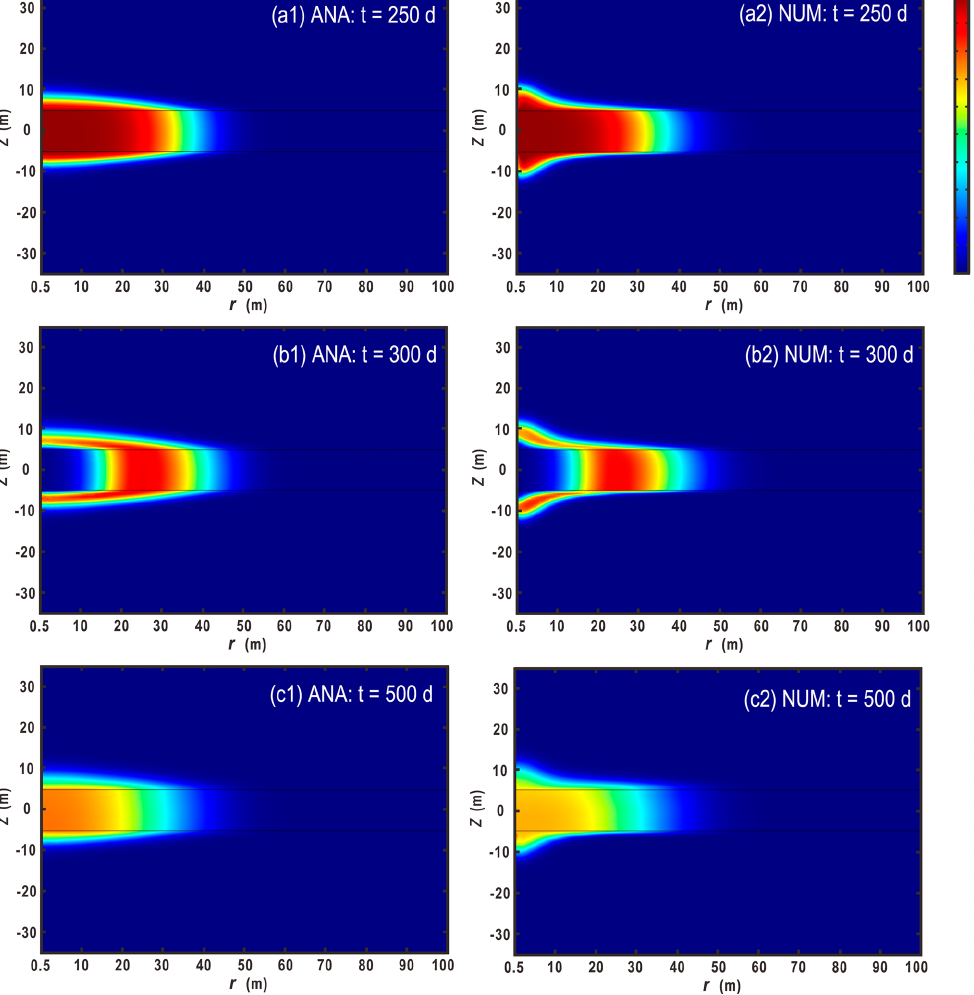
Figure 4. The vertical profiles (the r − z profiles) of the concentrations. Panels (a1) , (b1) and (c1) represent the analytical solutions at t = 250, 300 and 500d, respectively. Panels (a2) , (b2) and (c2) represent the numerical solutions at t = 250, 300 and 500d, respectively.